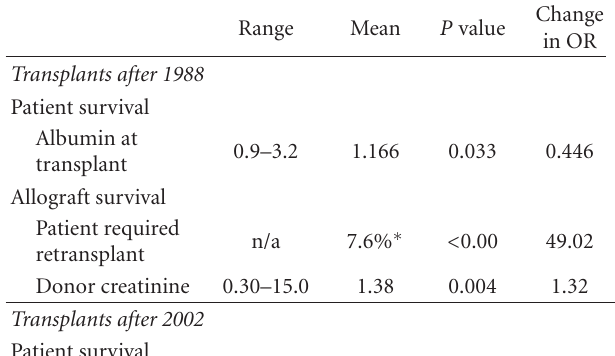
Table 2: Multivariate Cox regression results of clinical variables found to be significant ( P ≤ 0 . 05). ∗ Signifies percentage of sample who required